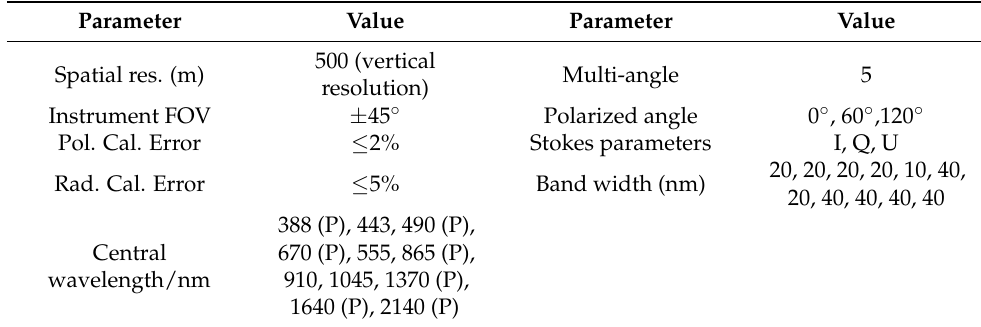
Table 1. Basic characteristics of MAPMU.